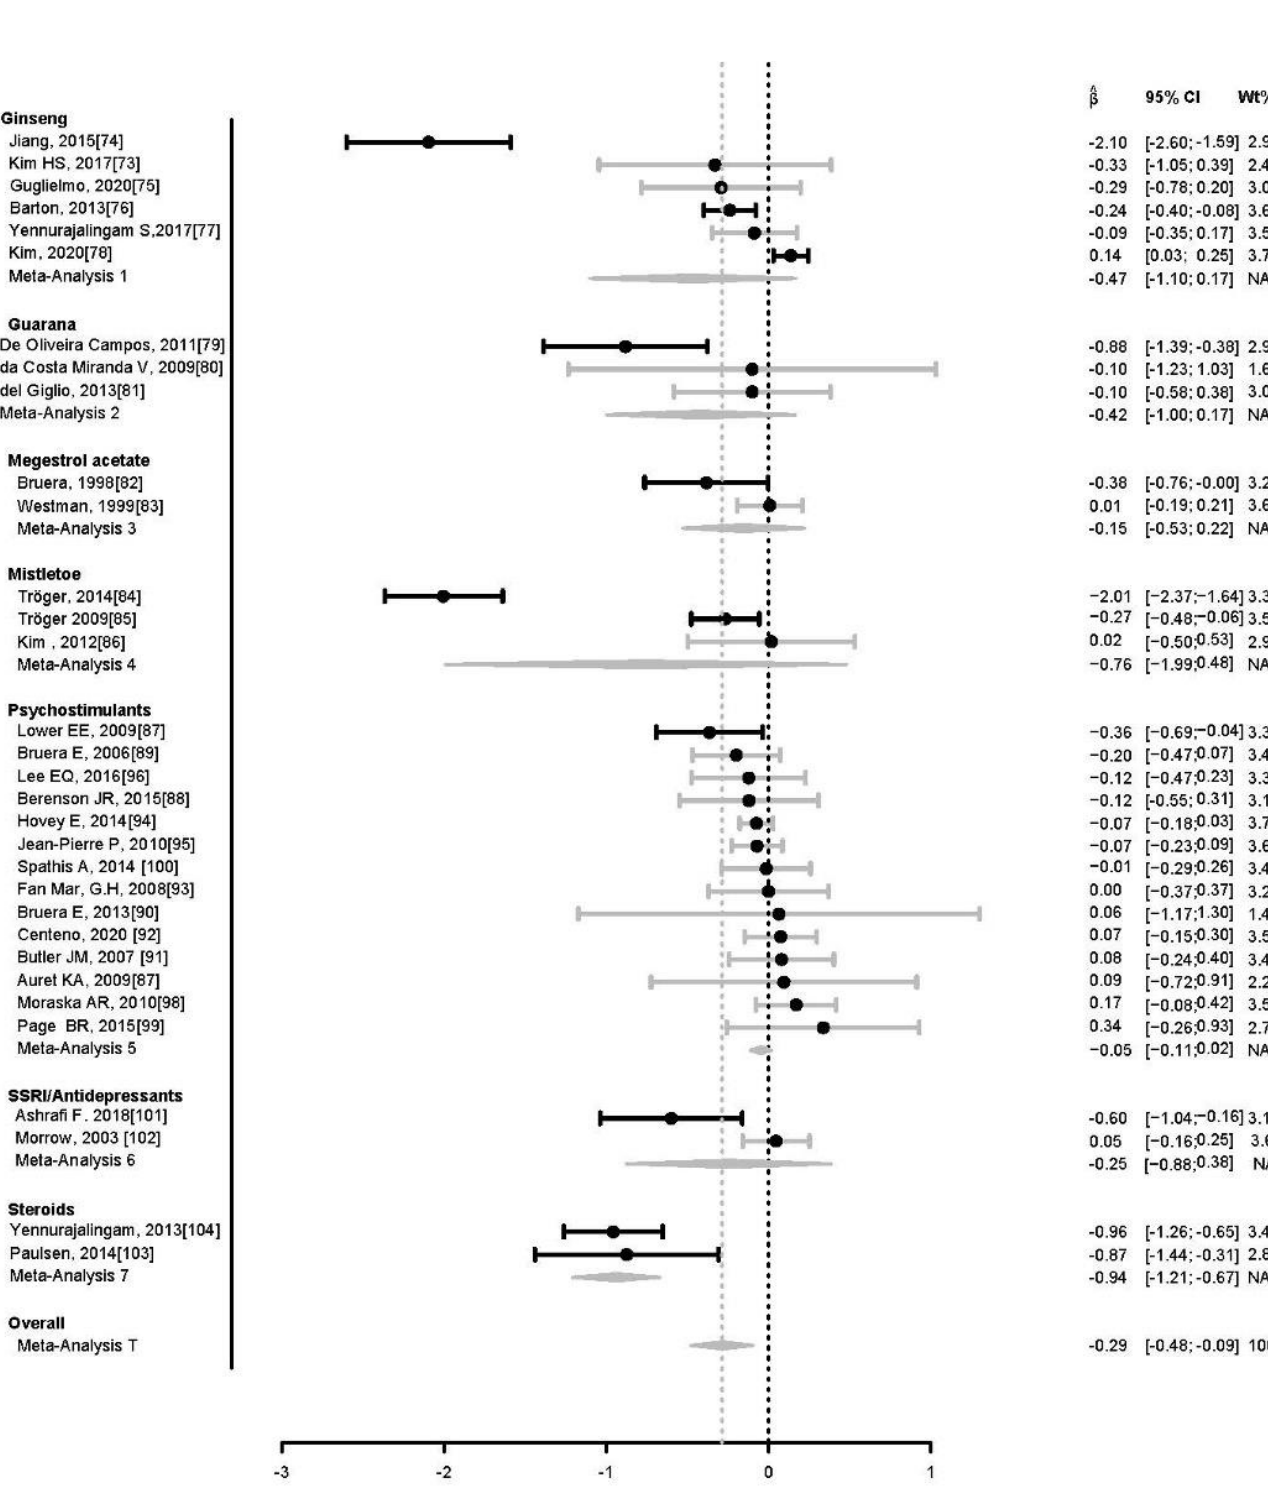
Figure 2. Meta-analyses of pharmacological, nutraceutical, and phytopharmaceutical treatments on Cancer related Fatigue using a forest plot.